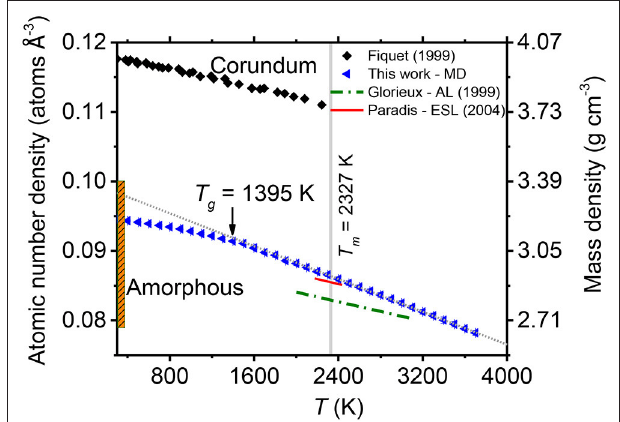
FIGURE 1 | The temperature dependence of the density of corundum and liquid alumina. The densities of liquid and amorphous Al 2 O 3 obtained by MD modeling in this paper are shown as blue triangles. The intersection of linear extrapolations of the density for the amorphous solid and the liquid yield the glass transition temperature of the model shown. The red (solid) and green (broken) lines show the experimental densities obtained by Paradis et al. (2004) and Glorieux et al. (1999), respectively. The experimental temperature-dependent densities of corundum are plotted as black diamonds (Fiquet et al., 1999). The vertical orange bar plots the range of room temperature densities of amorphous Al 2 O 3 thin films (see